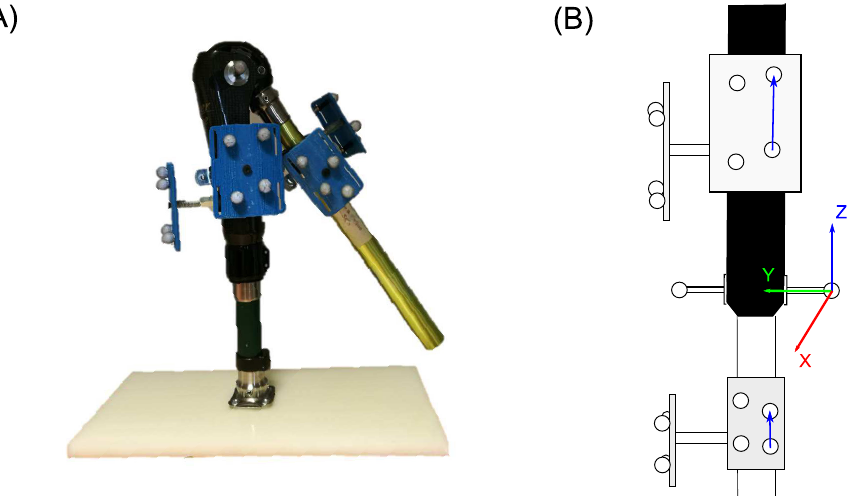
Fig 1. The mechanical linkage with a hinge joint. (A) The proximal segment was mounted on stand and remained static during movement while the distal segment was rotated manually about the joint. Marker clusters were attach to the front and lateral sides of both segments. The joint centre was determined using two markers placed on the two sides of the joint. (B) Joint coordinate systems were originated at the medial marker. Medial-lateral (y) axis was defined as a unit vector pointed to lateral joint marker from medial marker, inferior-superior (z) axis was perpendicular to y in the frontal plane of the corresponding segment in a superior direction and x axis was cross product of y and z axes.